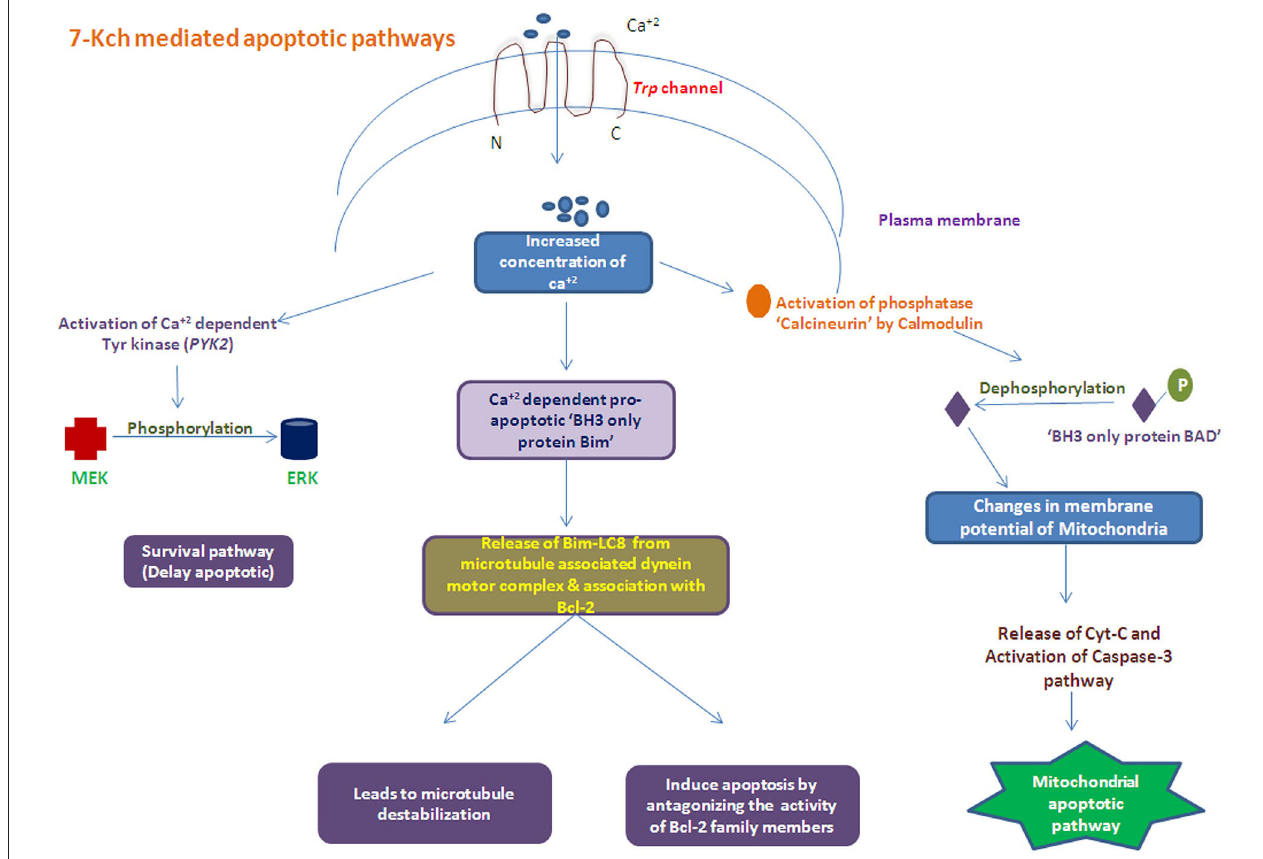
FIGURE 3 | Schematic of apoptosis process Induced with accumulated oxidized cholesterols (i.e., 7-Kch) by activating several apoptotic